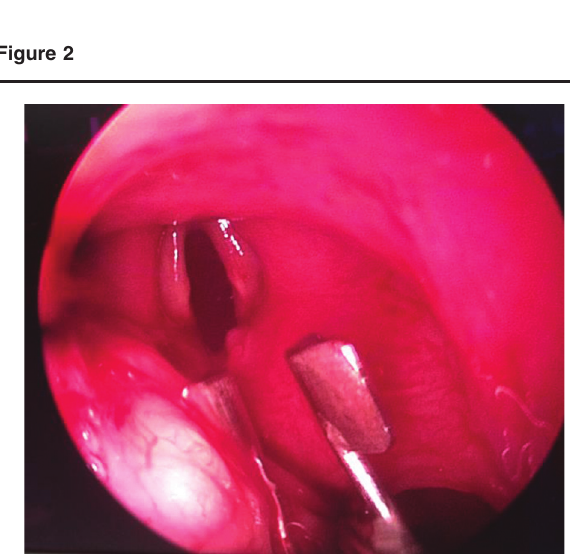
Laryngeal inlet with the mass.